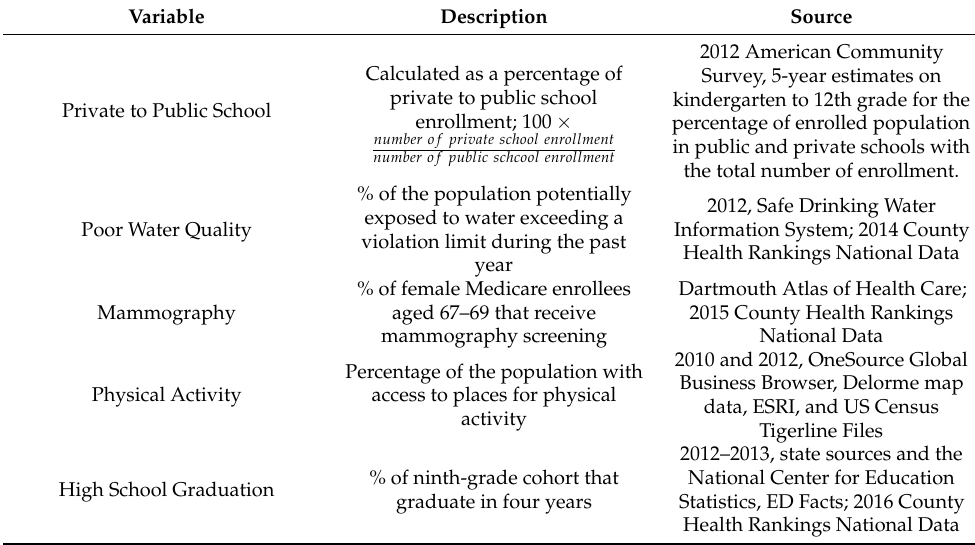
Table A4. Quality/outcomes of public